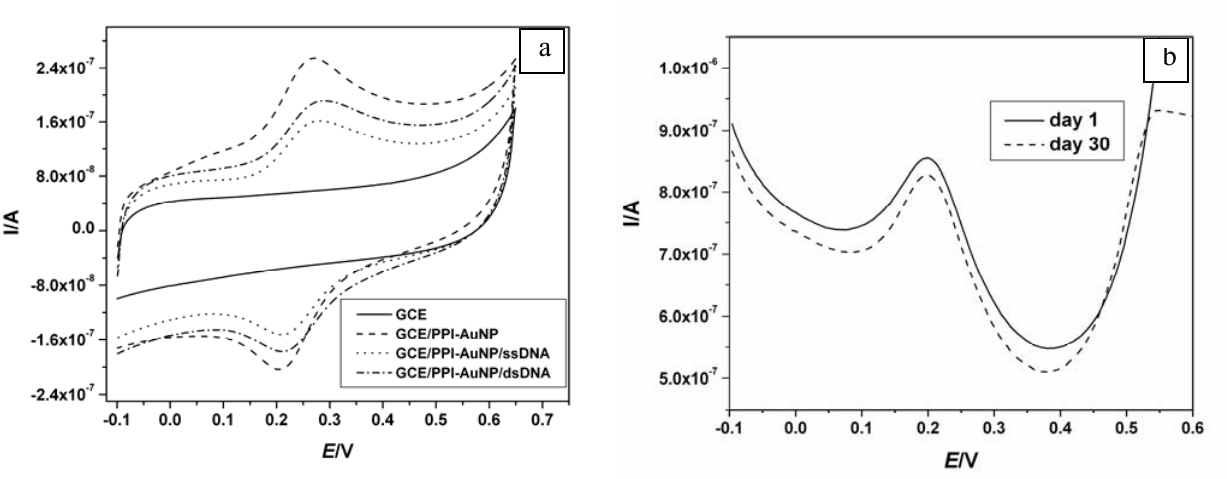
Figure 6. (a) CV of GCE/PPI-AuNP/ssDNA (developed with 2 µM thiolated ssDNA) and GCE/PPI-AuNP/dsDNA (i.e. response to 0.5 nM DNA target ssDNA) in PBS at 20 mV/s. (b) Differential pulse voltammograms of GCE/PPI-AuNP/ssDNA biosensor in PBS when stored for 30